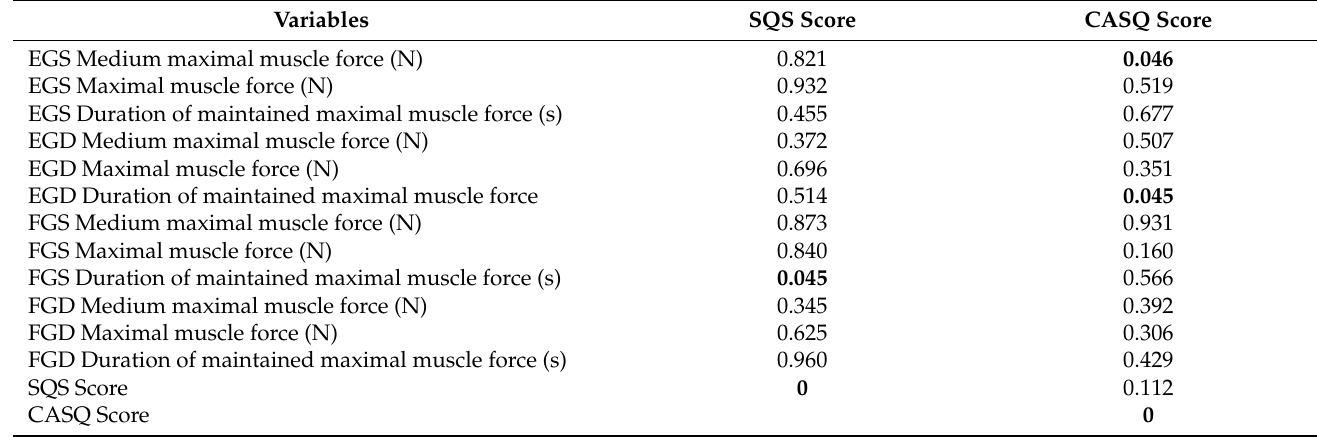
Table 20. p -values for Pearson correlation between SQS, CASQ scores and muscle parameters of left and right knee extensors and